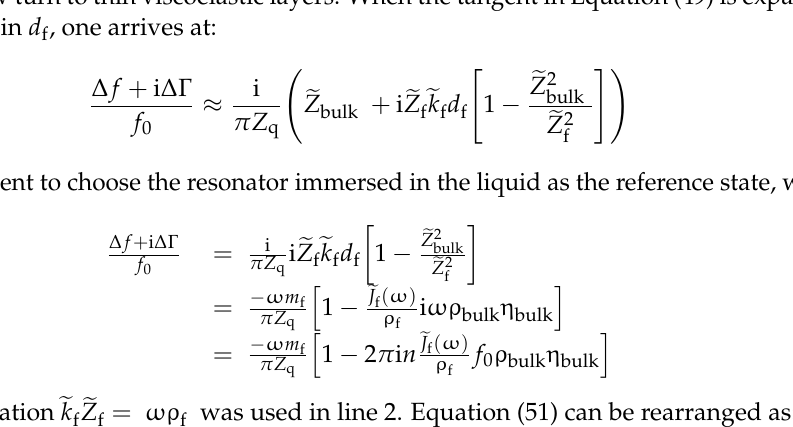
(cid:16) (cid:17) (cid:101) k f d f